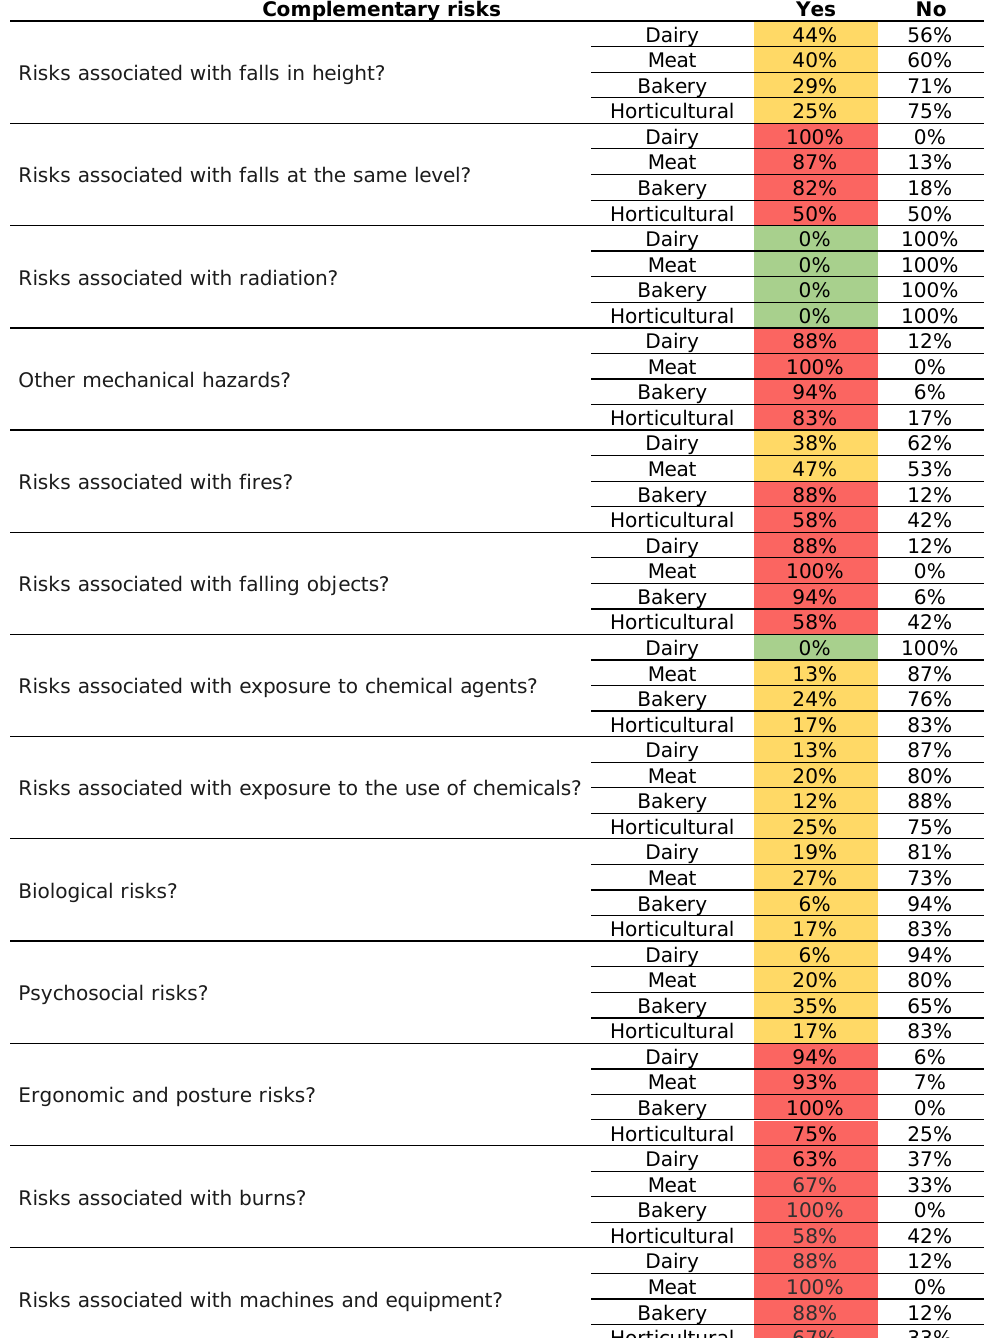
Table 9. Complementary risks in the audited